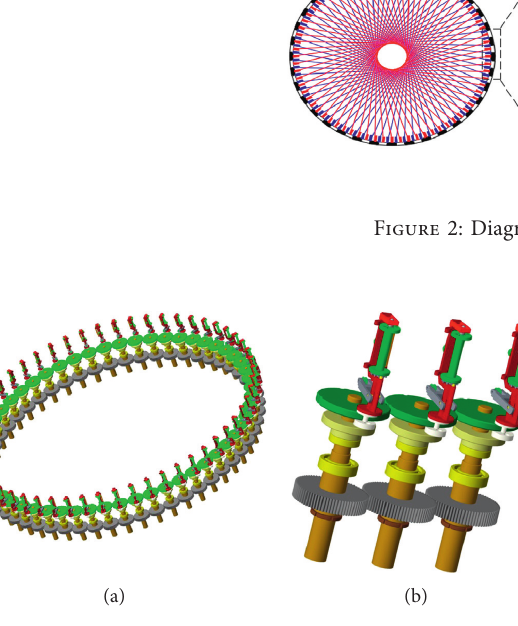
Figure 3: (a) Diagram of a closed-loop gear transmission system in a 3-D circular braiding machine gear transmission system. (b) Partial diagram of the gear transmission system.